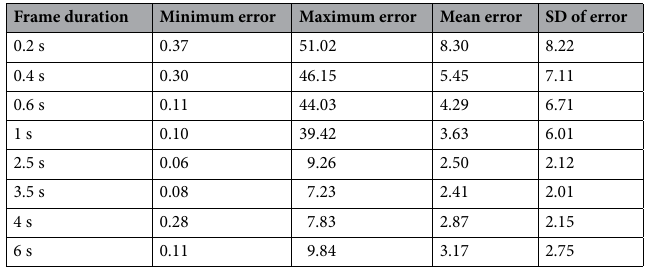
Table 4. Q max error rate statistics for different frame durations. SD Standard